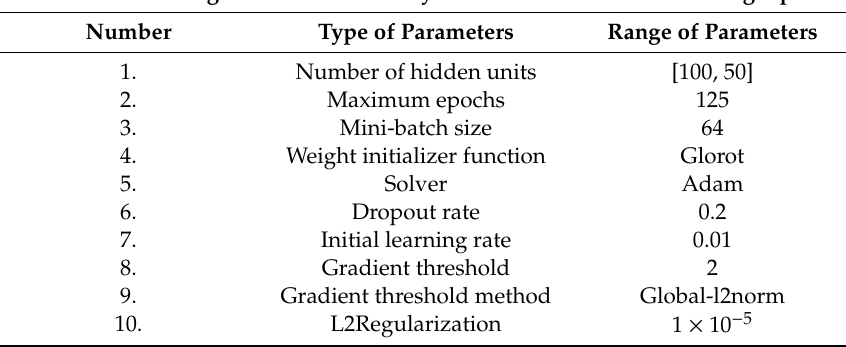
Figure 3. ( a ) Overall architecture for predicting impact acceleration magnitude during fall; ( b ) Detail architecture of long short-term memory network for fall accelerometer magnitude prediction. Table 2. Bi-directional long short-term memory (LSTM) network model parameters. Bi-Directional Long Short-Term Memory Network Architecture Training